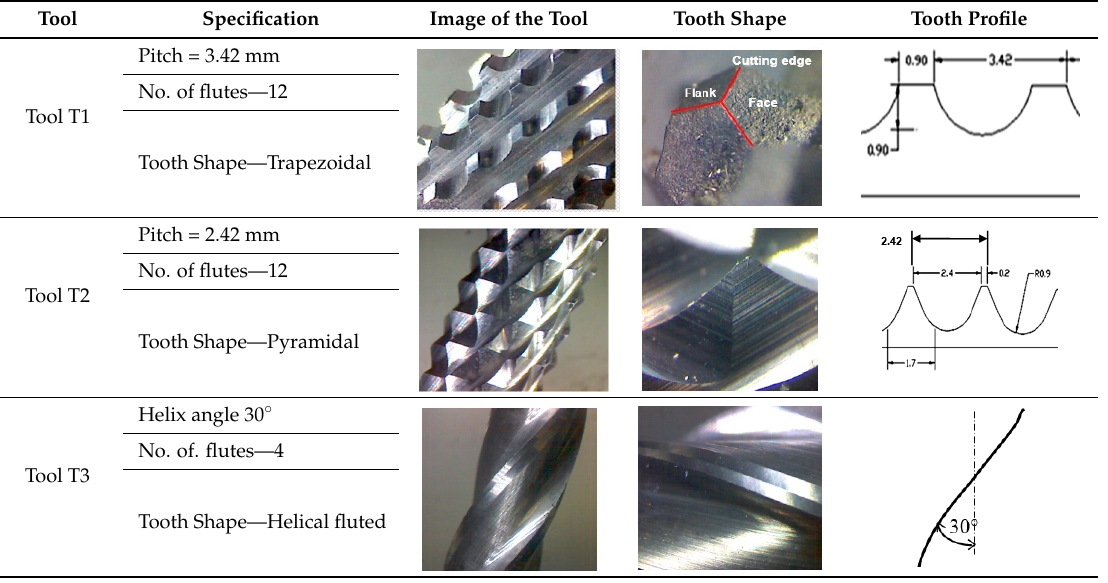
Figure 3. Edge trimming.